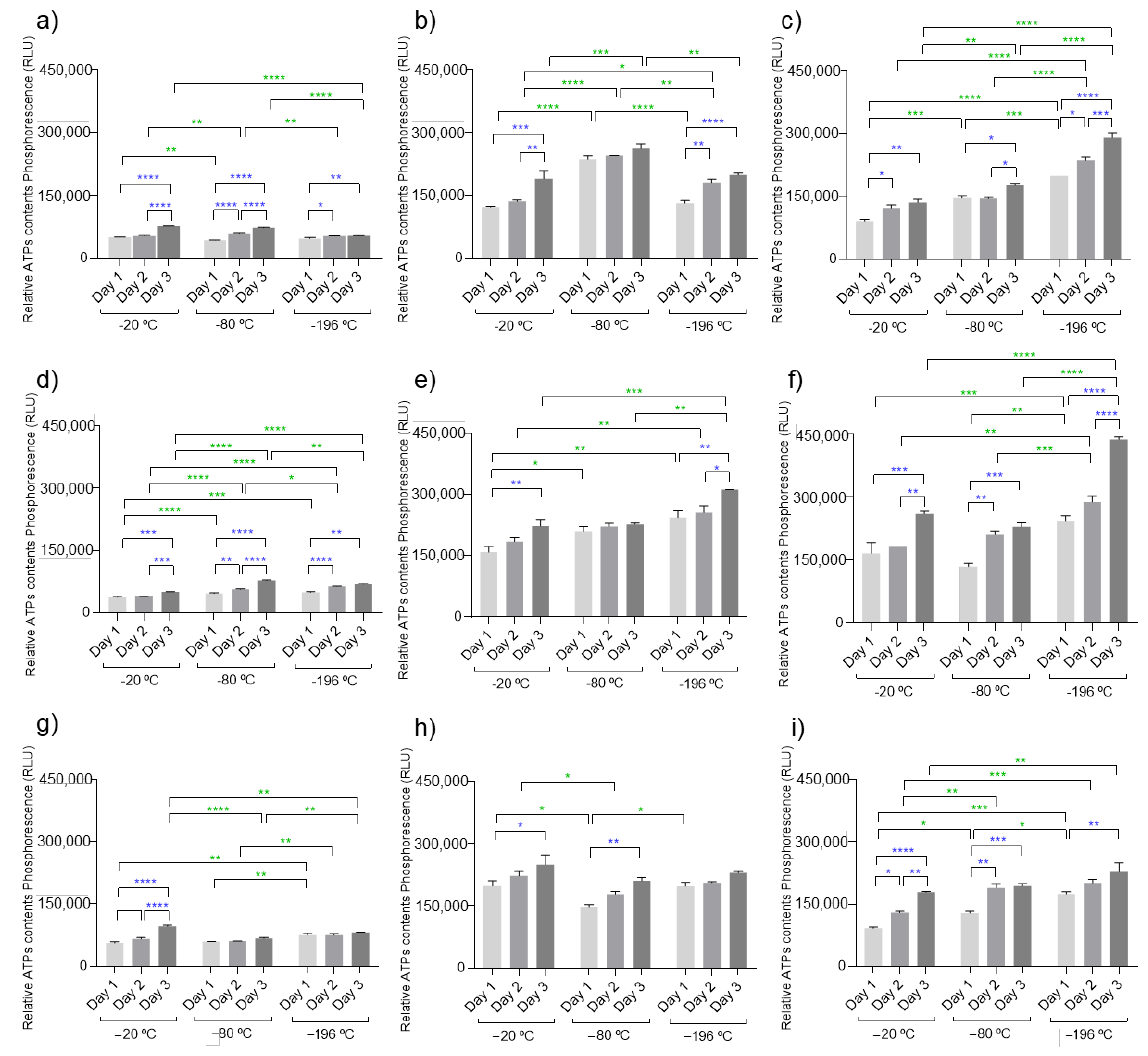
Figure 5. ATP cell measurements using ATDC5 cells in direct contact with all developed marine cryogels C 1 to C 9 (( a – i ), respectively) at − 20, − 80, and − 196 °C. There was a direct relationship between the measured phosphorescence and the concentration of ATP. The samples showed statistical significance of * ( p < 0.05), ** ( p < 0.01), *** ( p < 0.001), **** p < 0.0001, or were not significant (not represented). The symbols of statistical analysis noticeable by blue color correspond to the comparison between each condition in relation to the time points while the symbols expressed by green color represent the comparison between the different temperatures of each marine